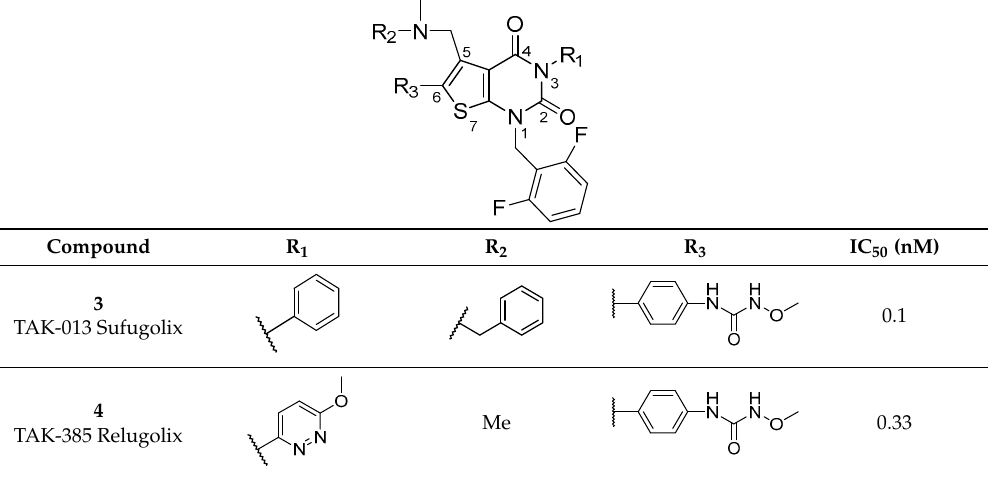
Table 2. Thieno[2,3- d ]pyrimidine-2,4-one derivatives and their binding affinity at human GnRH.